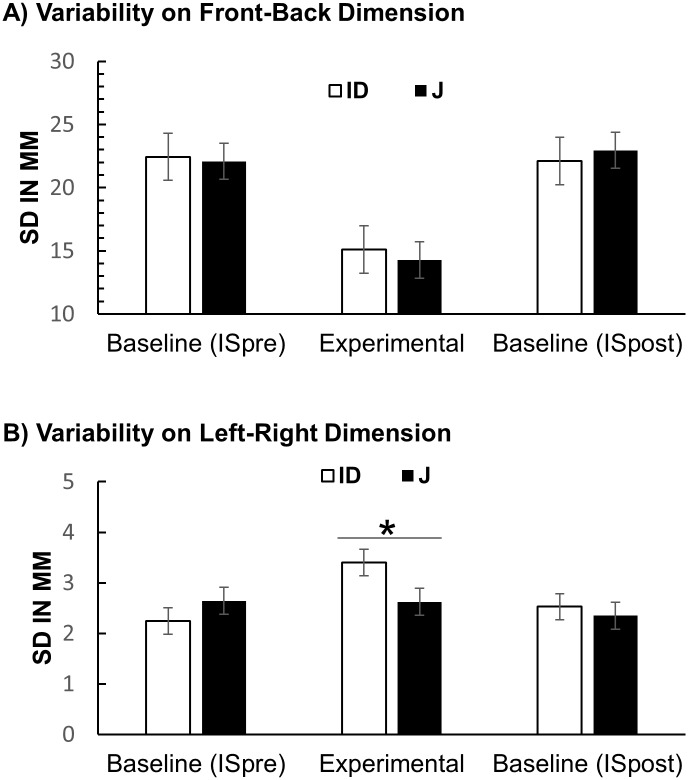
Results of Experiment 1: Variability of judgment errors.(A) Variability on egocentric front-back dimension. (B) Variability on egocentric left-right dimension. Error bars stand for within-subject 95% CI.